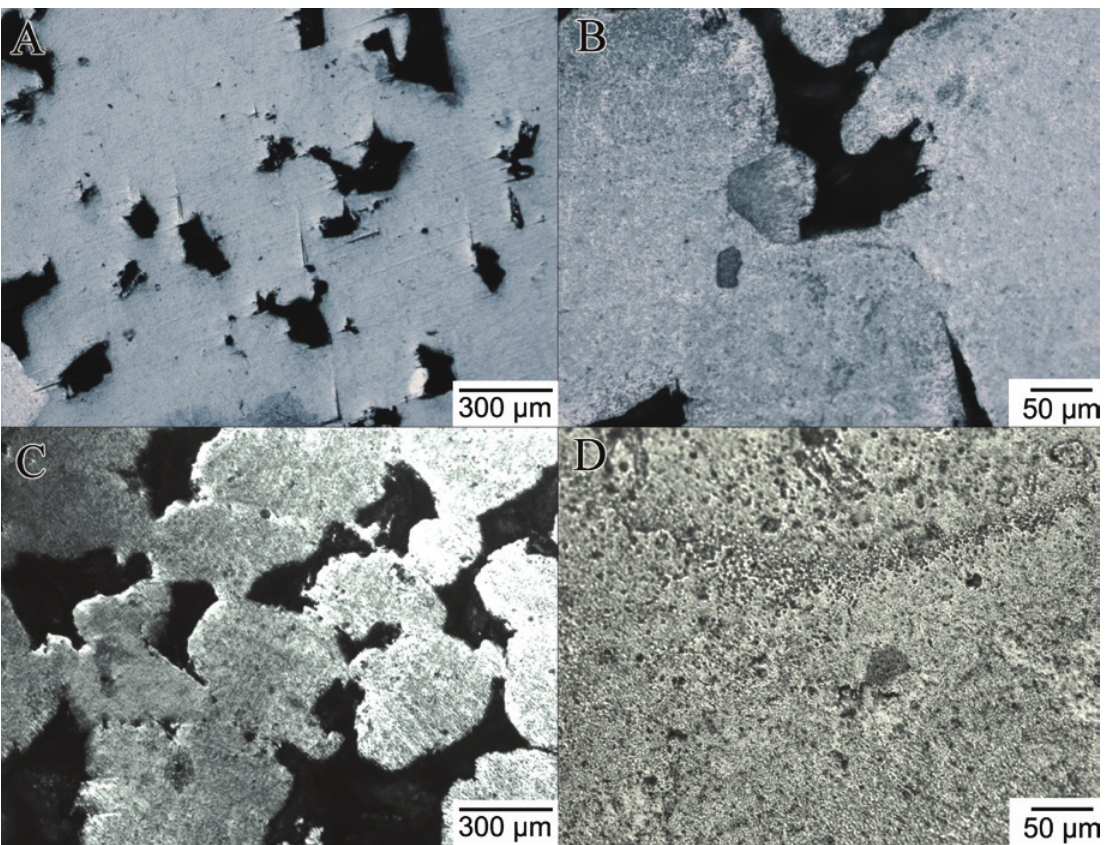
pellet at low magnification, (B) Al/NbB 2 pellet at higher magnification. 2